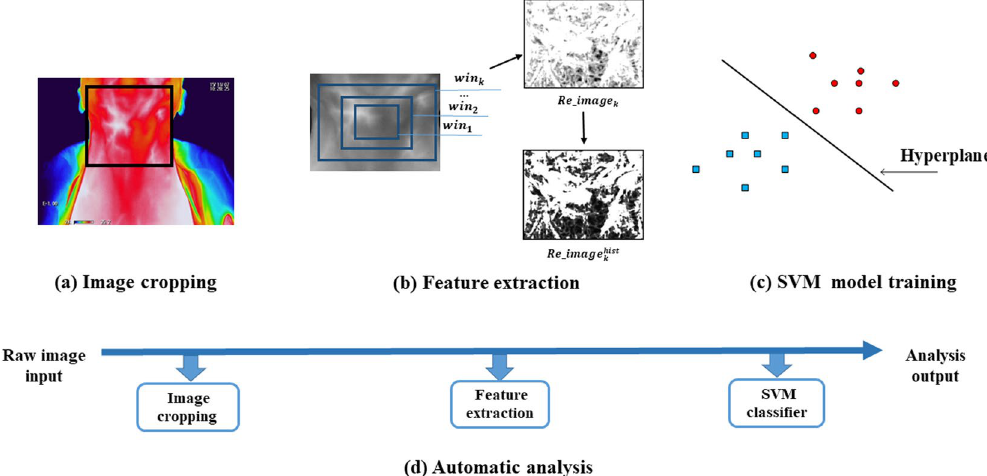
hist are used in the feature and Re image _ k k